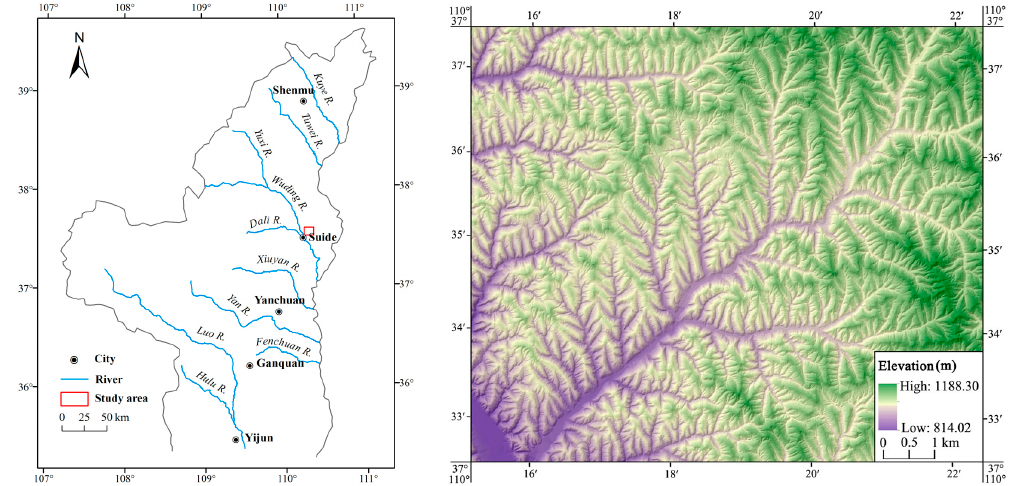
Figure 1. Location and digital elevation model (DEM) of the study area.